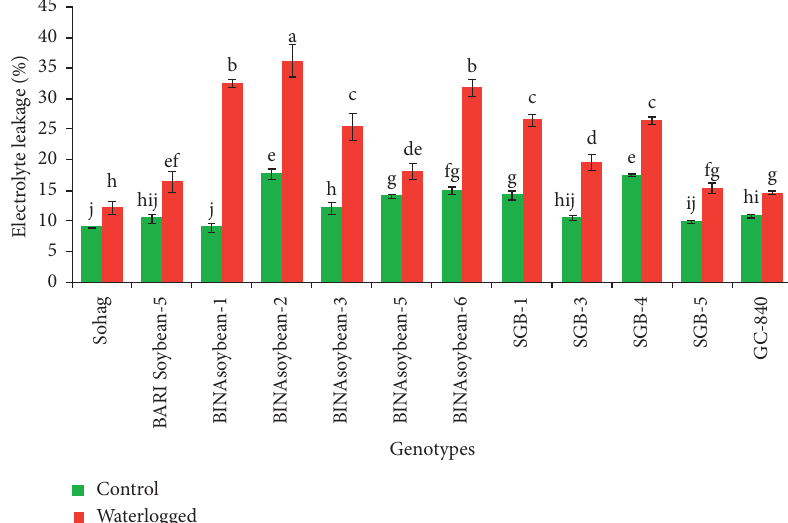
Figure 5: Effect of waterlogging stress on electrolyte leakage of different soybean genotypes. For each treatment, the mean ( ± SD) was determined from three replicates. Different alphabets on the bars indicate significant difference at P ≤ 0 . 05 after mean comparison by Fisher’s LSD